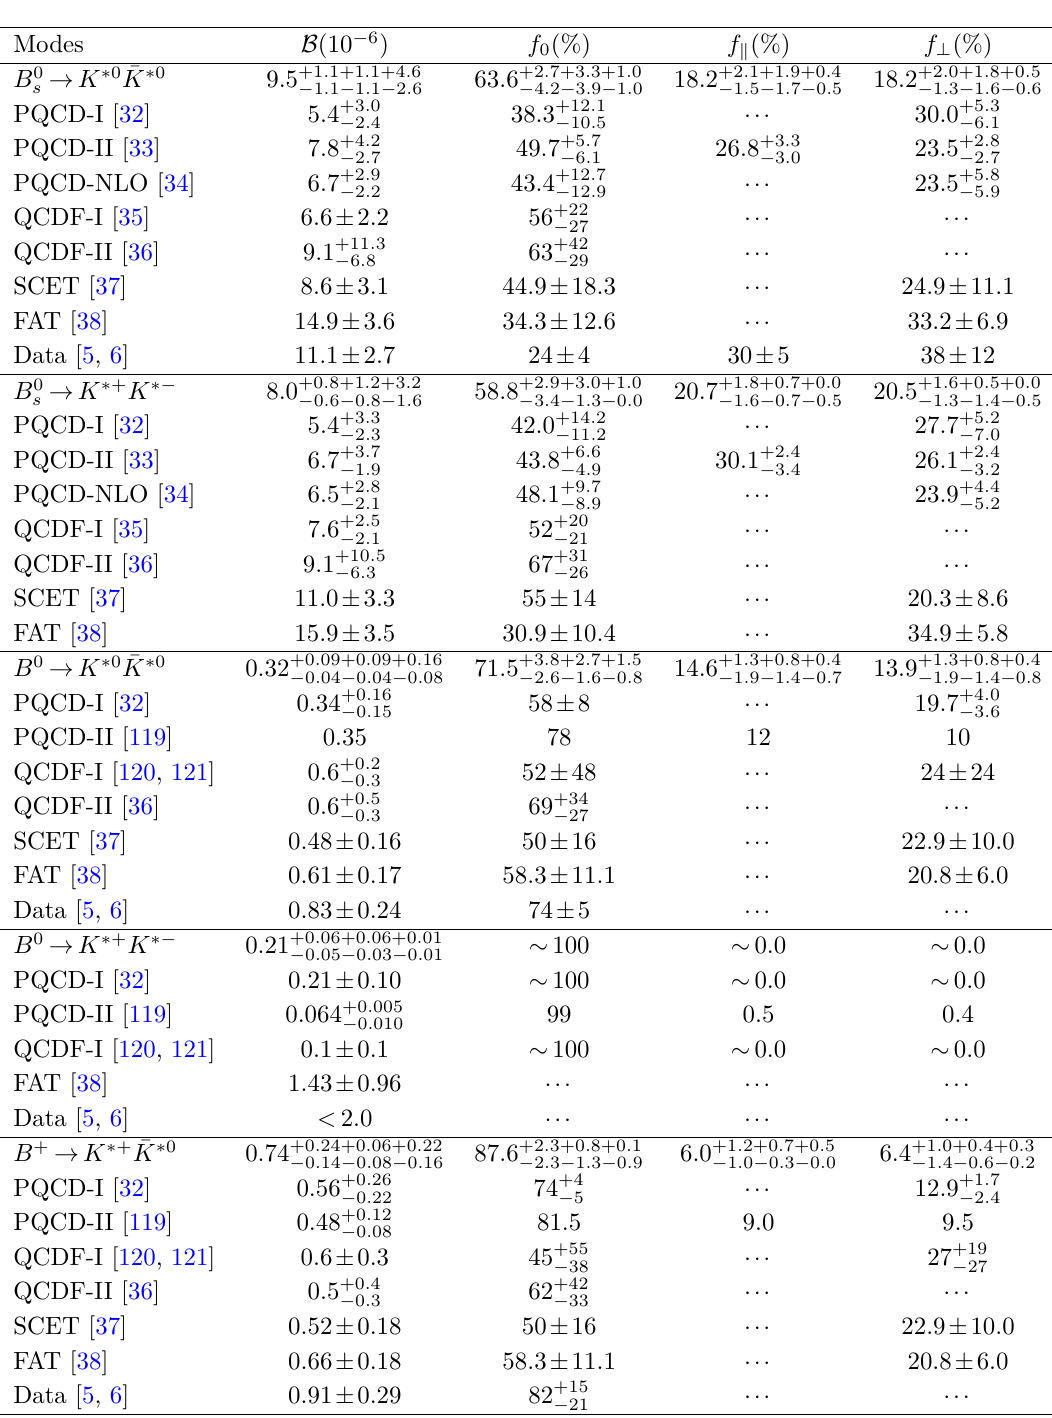
Table 3 . CP -averaged branching ratios and polarization fractions for the two-body B → K ∗ ¯ K ∗ decays. For comparison, we also list the results from PQCD [32–34, 119], QCDF [35, 36, 120, 121], SCET [37], and FAT [38]. The world averages of experimental data are taken from [5,